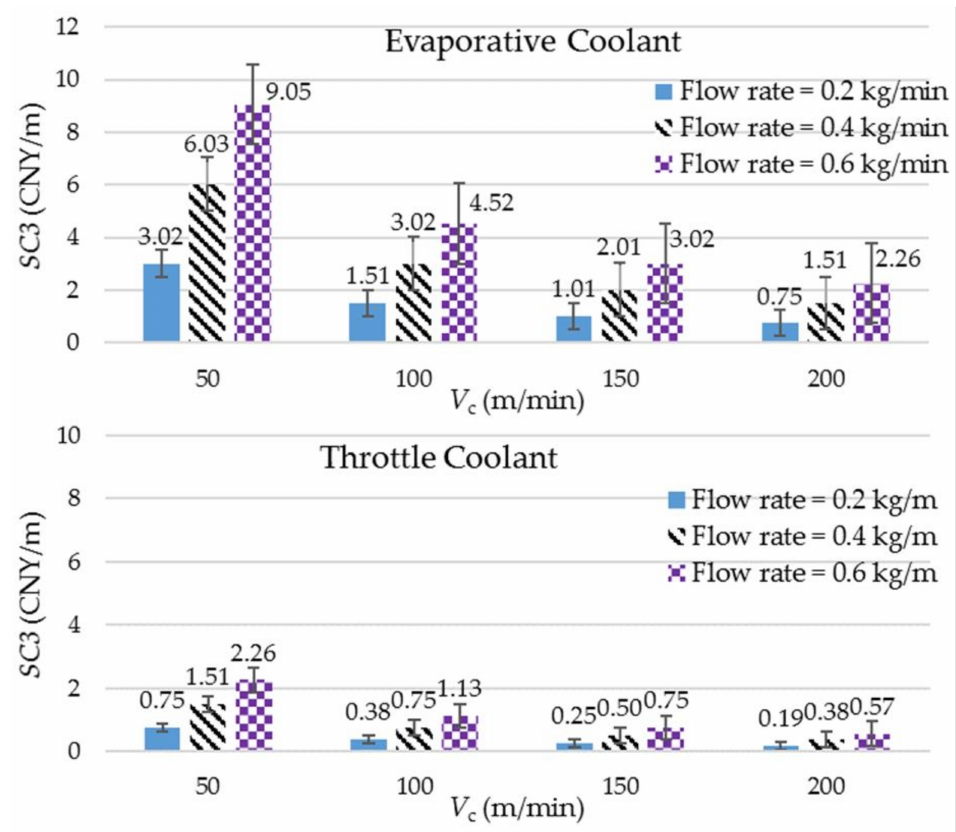
Figure 8. The calculated values of specific coolant consumption cost against different combinations of cutting speed and coolant’s mass flow rate. Table 3. Sustainability scores (SS) for the 28 runs, with rows arranged in the descending order of the SS values.